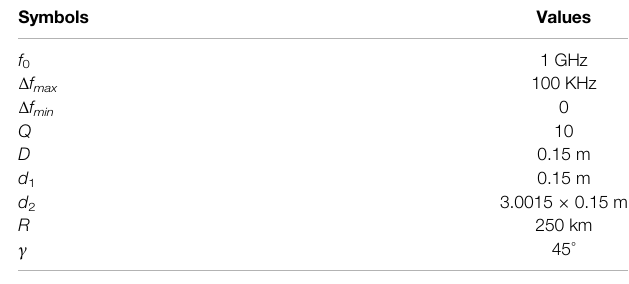
TABLE 1 | Main simulation parameters.